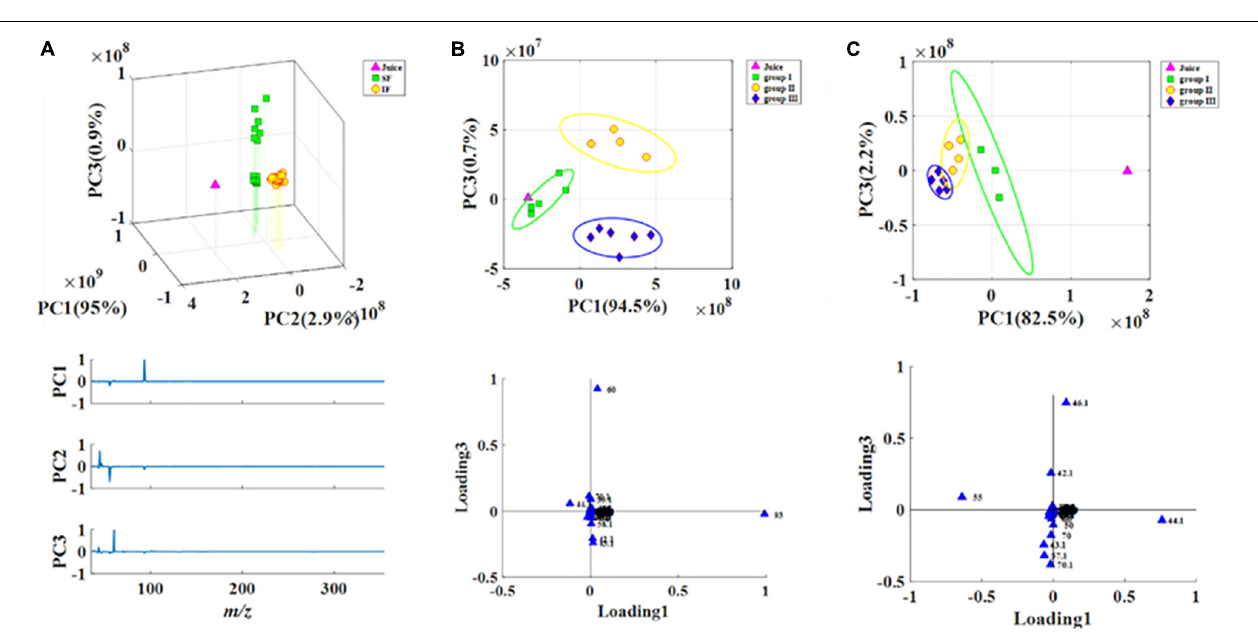
FIGURE 3 | PCA analysis of volatile compounds in fermentations ( A: Juice, SF, and IF; B: SF; C: